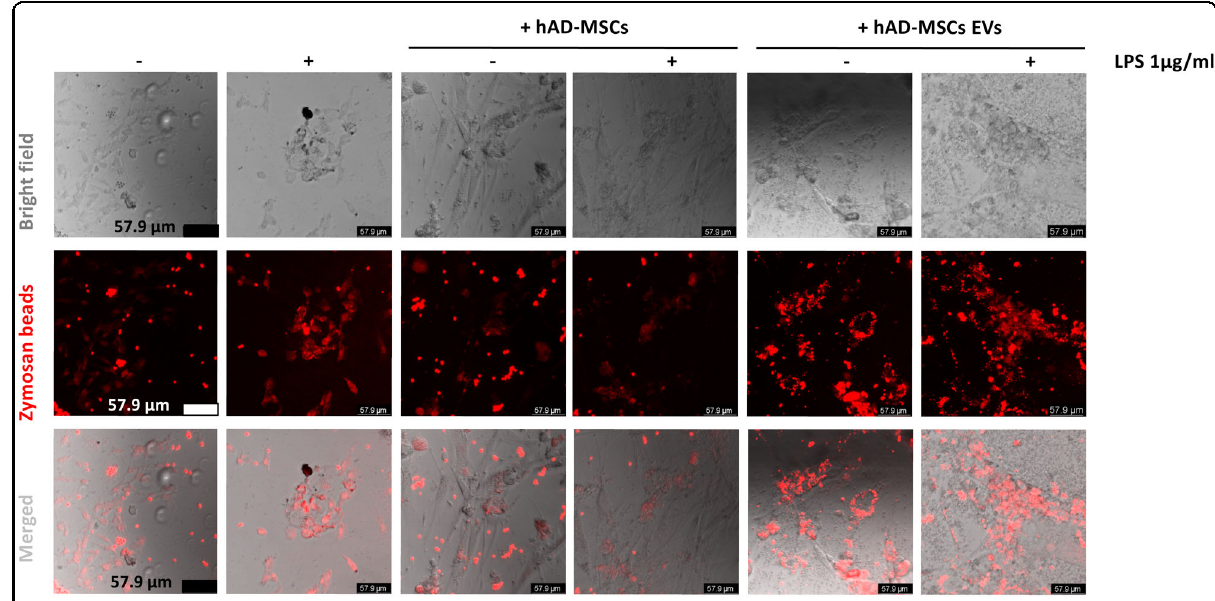
Fig. 5 Human adipose tissue-derived stem cells secreted extracellular vesicles enhanced phagocytosis in human HMC3 microglia. Representative images of untreated or LPS-stimulated HMC3 microglia capacity of phagocytize fl uorescent-labeled latex